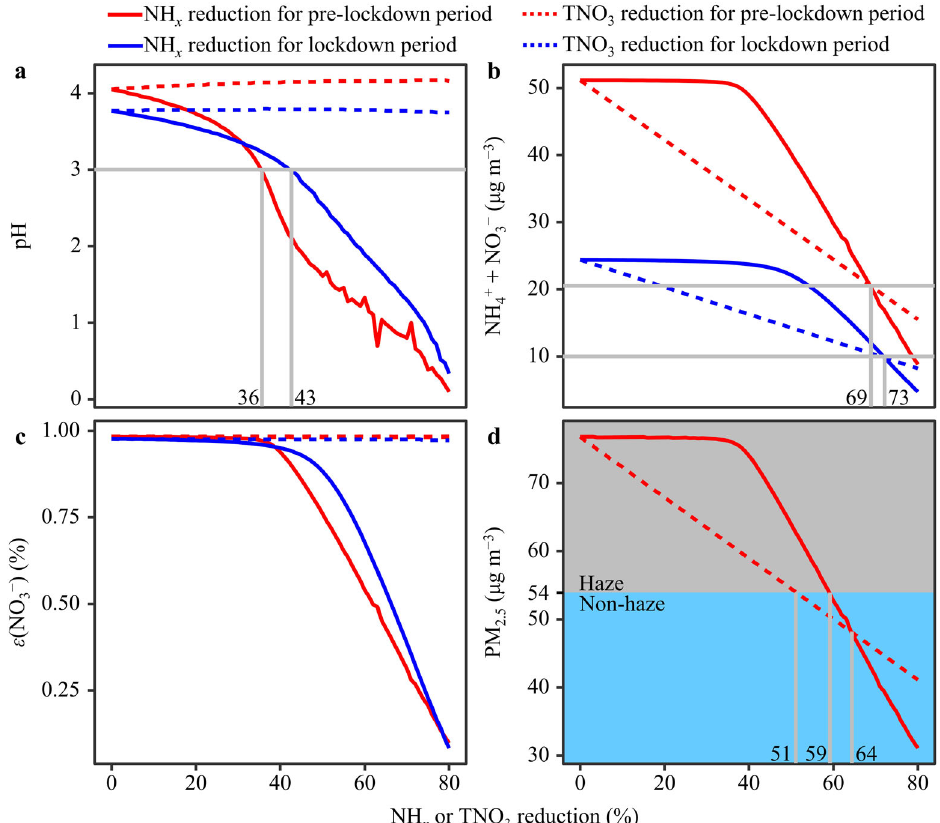
Fig. 5 Relative merits of NH x and TNO 3 controls on various aspects of PM 2.5 . Aerosol pH ( a ), mass concentration of [NH 4 + + NO 3 − ] ( b ), proportion of particle nitrate ( ε (NO 3 − )) ( c ), and PM 2.5 mass concentration ( d ) predicted by ISORROPIA-II model. The simulations are based on the average values, with changes only from NH x or TNO 3 . The horizontal gray solid line in a identi fi es the critical pH value of 3 86